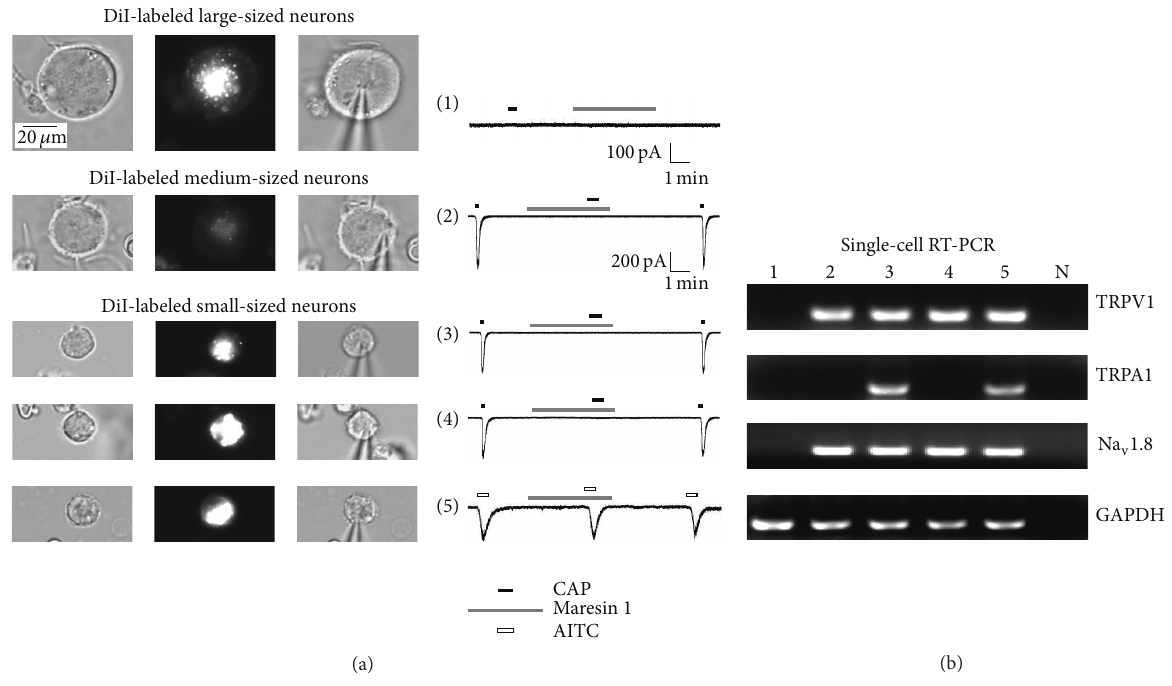
Figure 3: Voltage-clamp recordings and single-cell RT-PCR in five DiI-labeled TG neurons. (a) Representative DiI-labeled large-, medium-, andsmall-sizedTGneuronsarevisualizedunderphase-contrast(left)andfluorescent(middle)images,respectively.Therightimageshowsthe whole-cell patch clamp recording mode in DiI-labeled neurons. Capsaicin (CAP, 100nM) did not induce inward currents in DiI-labeled large- sized neuron (#1). Three neurons (#2, #3, and #4) responded to capsaicin with inward currents, which were completely blocked by maresin 1 (0.35 nM). Note that maresin 1 (0.35 nM) did not inhibit AITC-induced (300 𝜇 M) TRPA1 currents in DiI-labeled small-sized neuron (#5). (b) Single-cell RT-PCR analysis following voltage-clamp recording in five DiI-labeled TG neurons. GAPDH is the positive control. 𝑁 is the negative